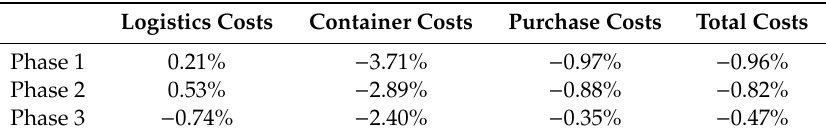
Table 4. Costs variation increasing 50% the suppliers’ availability.